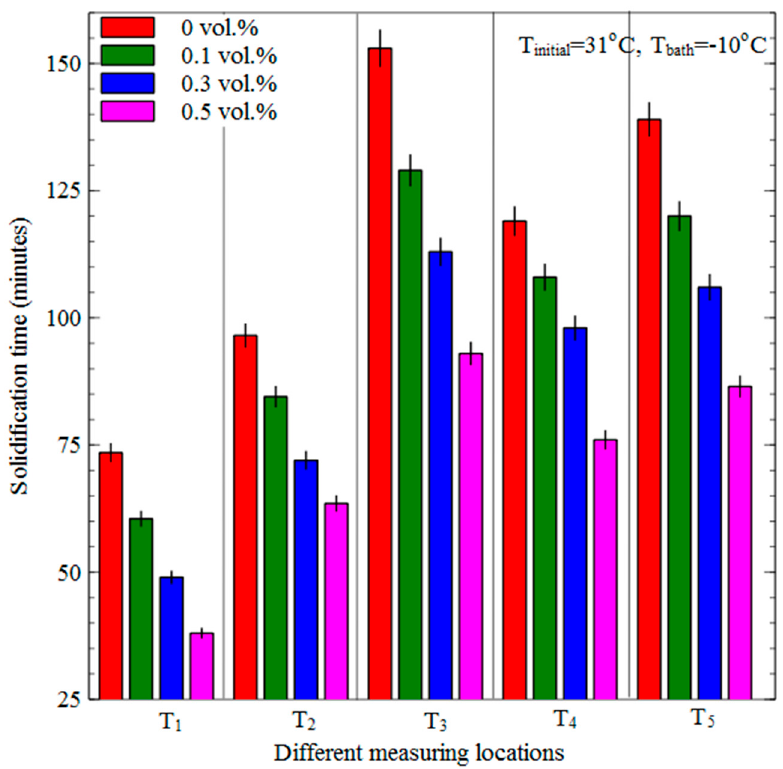
Energies 2019 , 12 , x FOR PEER REVIEW Figure 9. Solidification time of the PCM nanocomposites at di ff erent locations inside the sphere. Figure 9. Solidification time of the PCM nanocomposites at different locations inside the sphere.